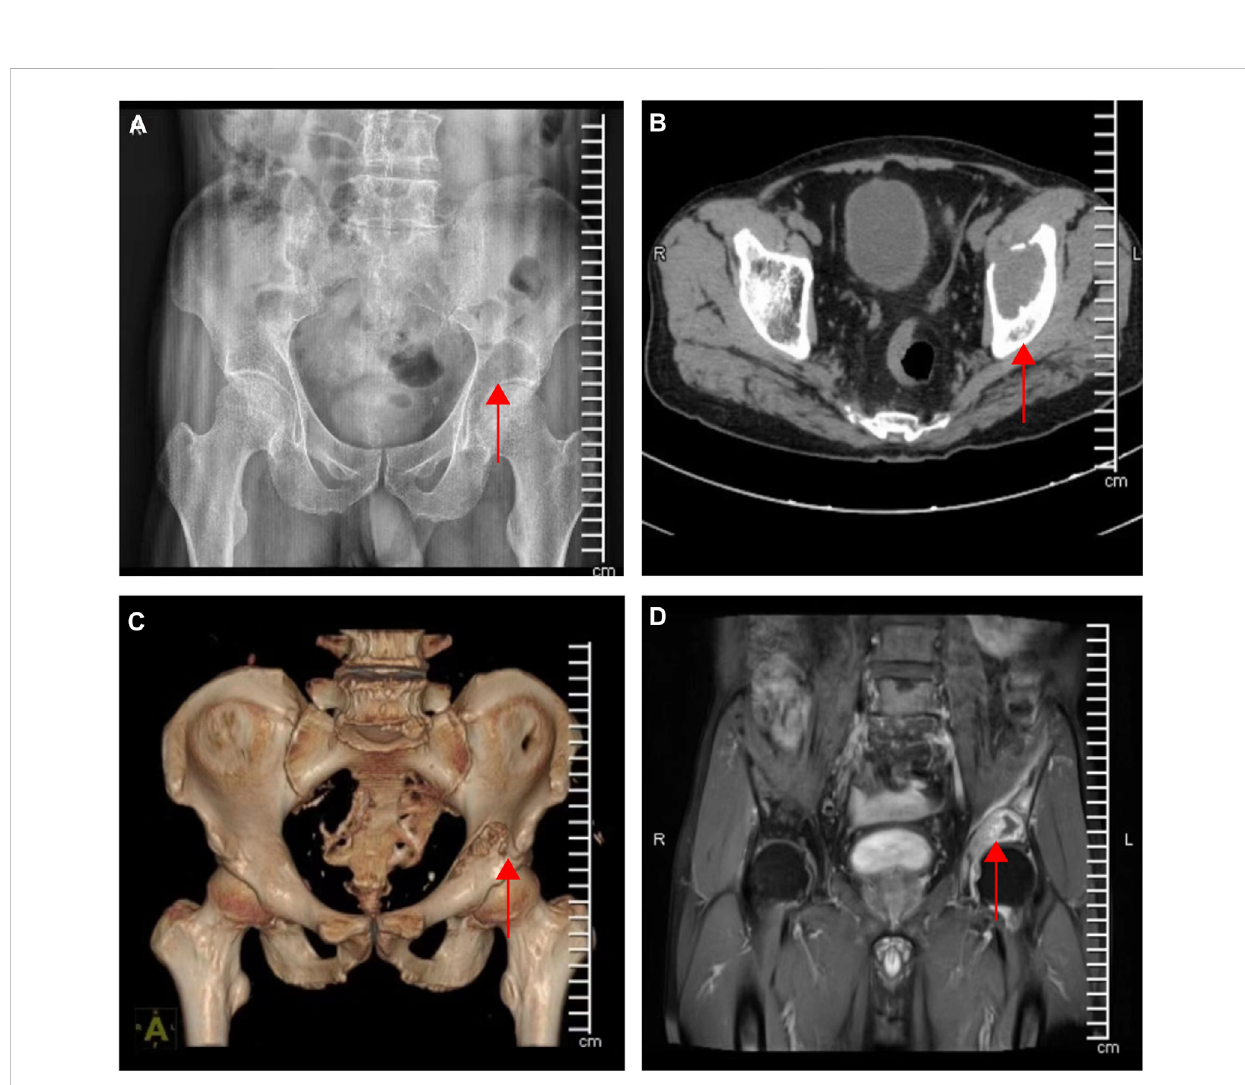
FIGURE 1 Preoperative imaging data of acetabular metastases. (A) Lesion under X-ray radiographs (B – C) CT and 3D reconstruction of the lesion (D) Magnetic resonance imaging of the lesion (the red arrow indicates the site of the